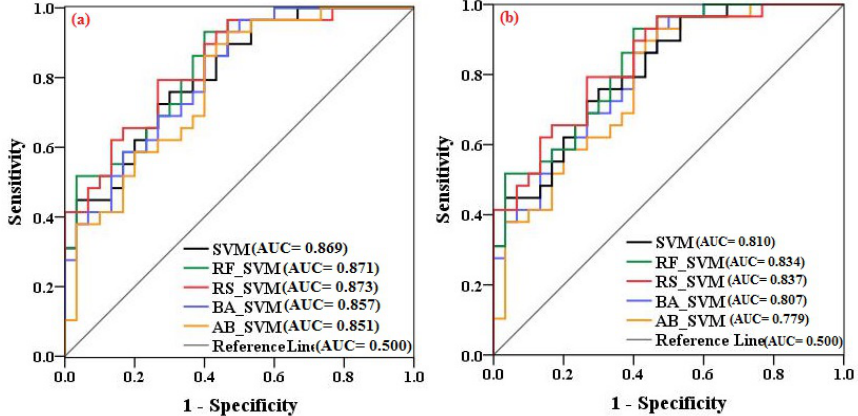
Figure 9. AUC results of models using: ( a ) the validation dataset and ( b ) the training